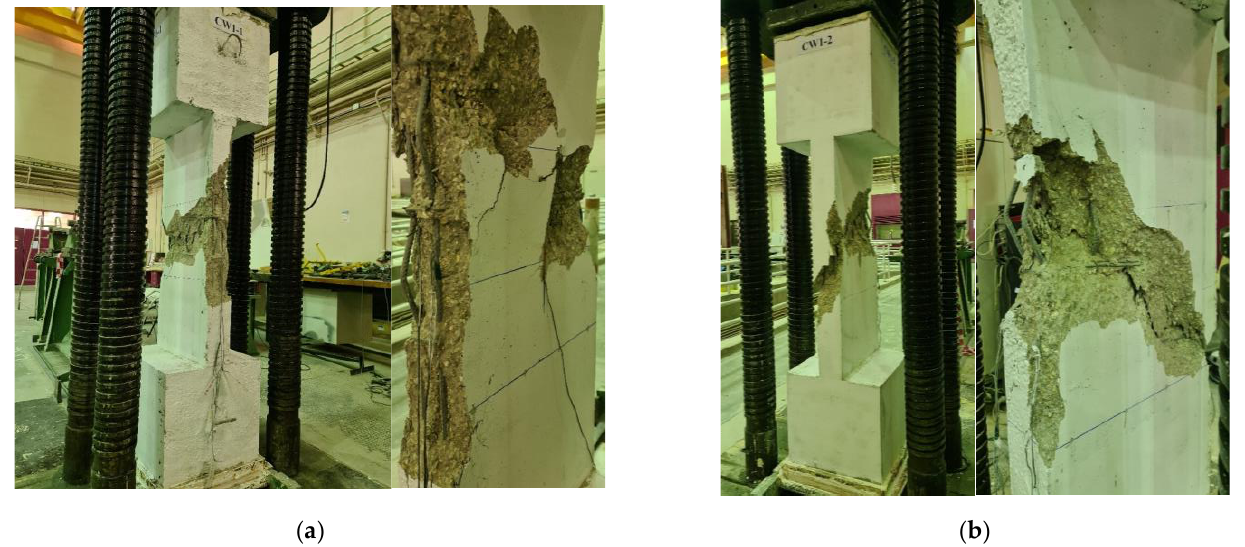
Figure 12. Failure mode of control columns: ( a ) specimen CW1; ( b ) specimen CW2.